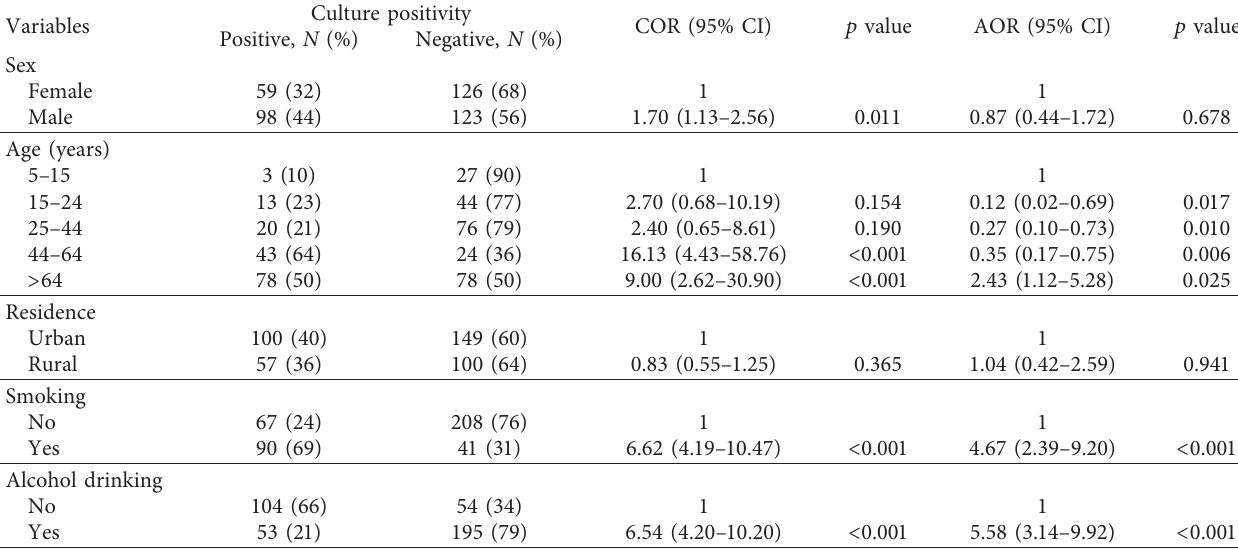
Table 5: Multivariable logistic regression analysis of culture positivity identified from pneumonia suspected patients, Dessie,